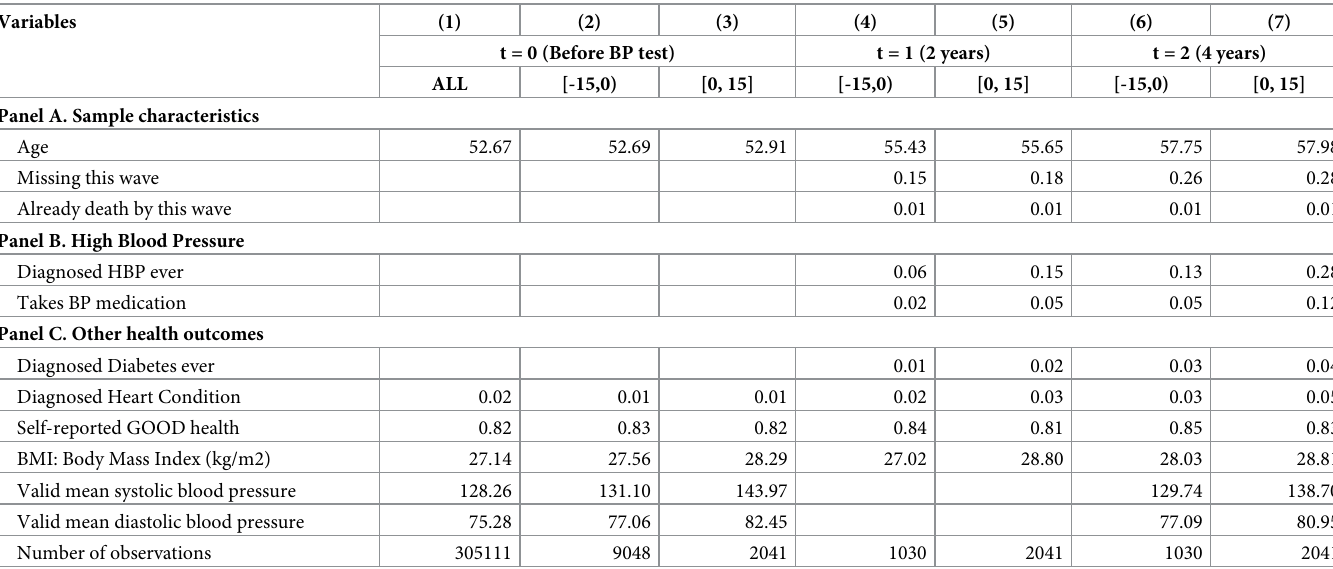
Table 2. Dependent variables’ means by